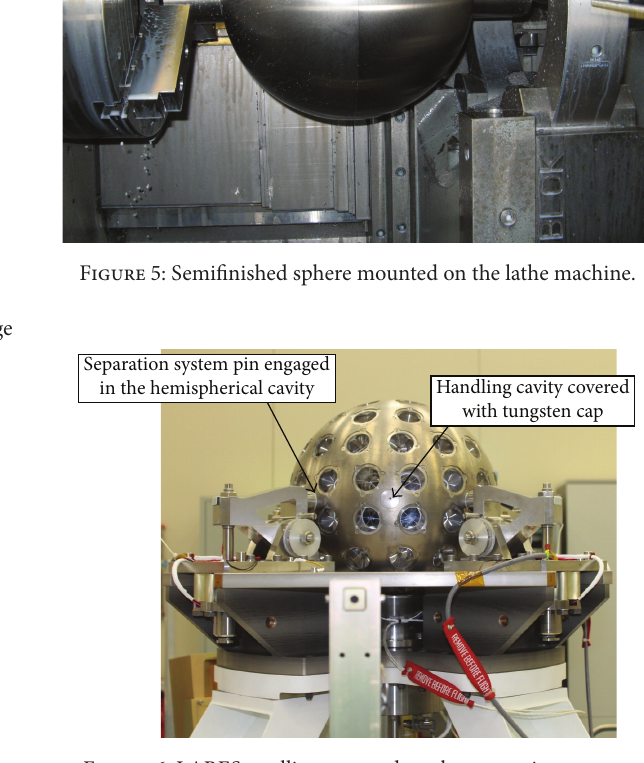
Figure 6: LARES satellite mounted on the separation